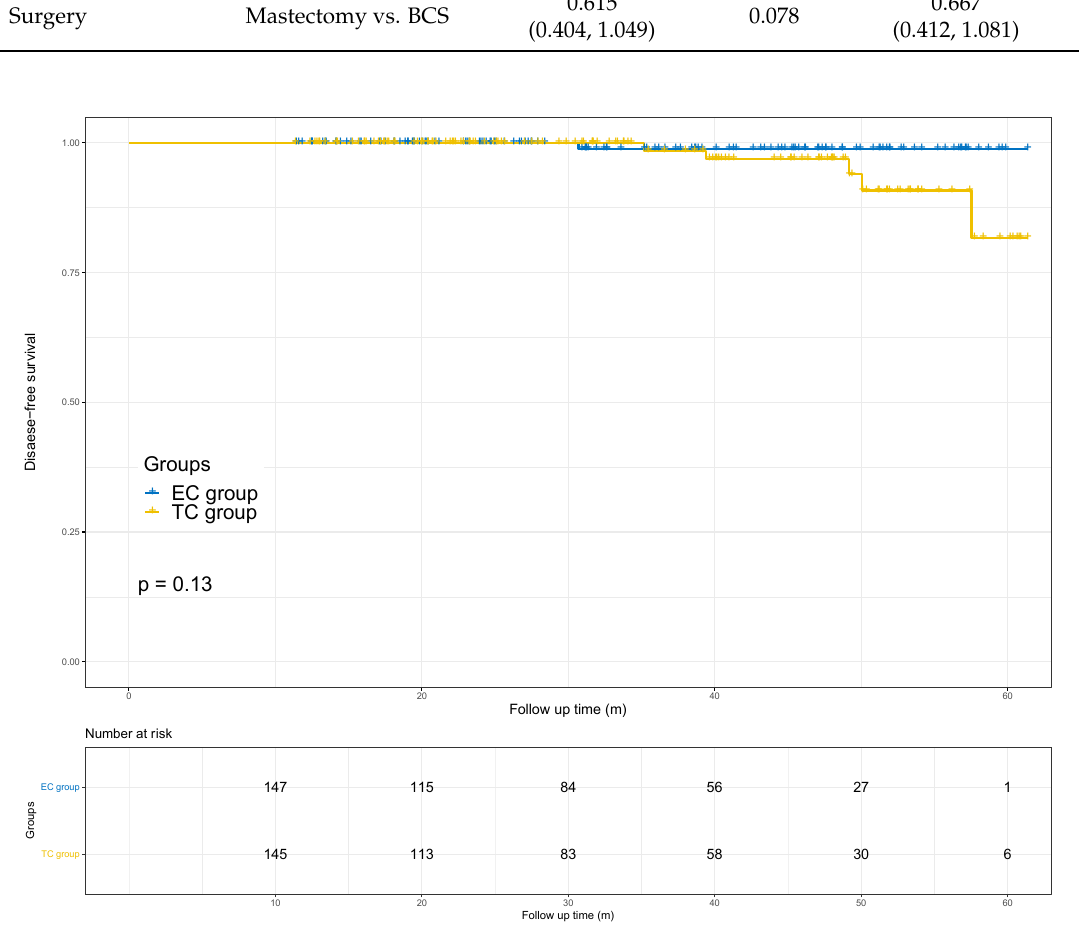
Figure 3. The comparison of the disease-free survival rates between the two groups. With a median follow-up of 33 months, no significant difference was observed between two groups (HR 4.51 [95% CI 0.52, 38.80], log-rank p = 0.13). Abbreviations: EC = epirubicin and cyclophosphamide; TC = docetaxel and cyclophosphamide.